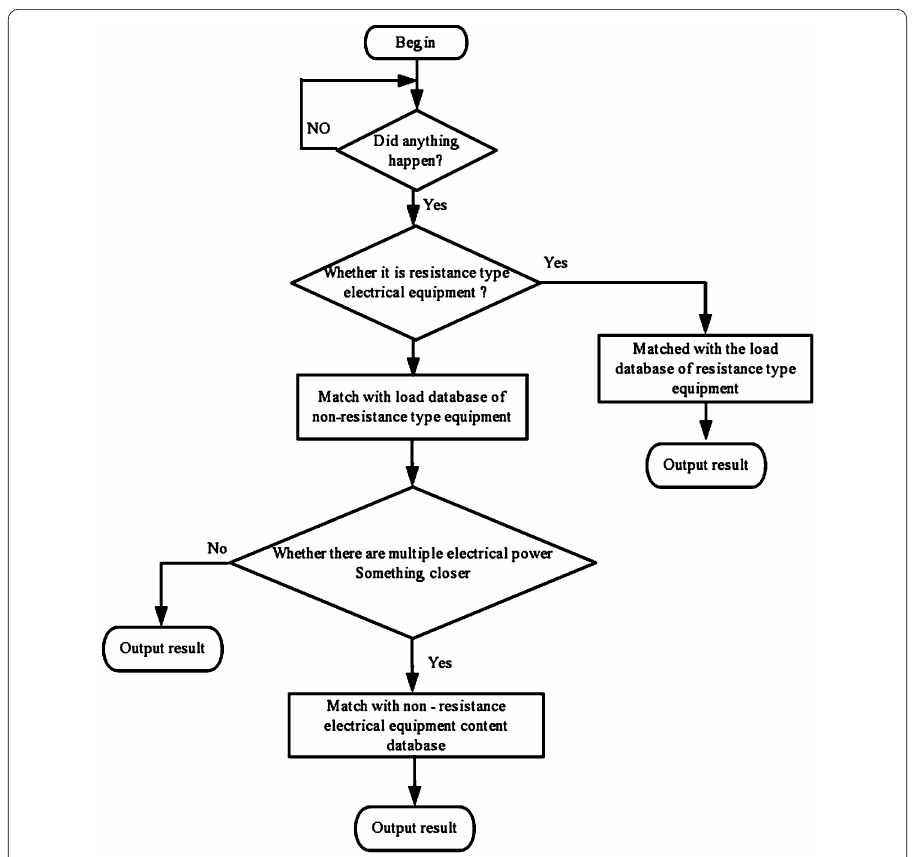
Figure 2 Flow chart of load identification decision tree